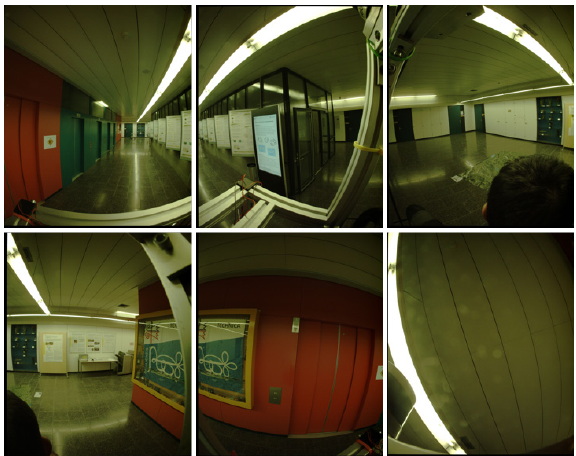
Figure 10. Images captured at the same location (see Figure 8) from the upward facing camera head cam5 (bottom right), backward pointing camera head cam0 (top left) and the consecutive camera heads cam1 (top middle), cam2 (top right), cam3 (bottom left), cam4 (bottom middle)